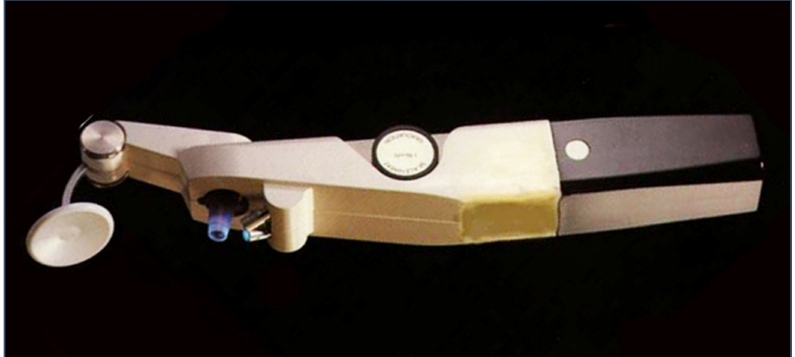
Figure 4. Handheld Perkins tonometer.